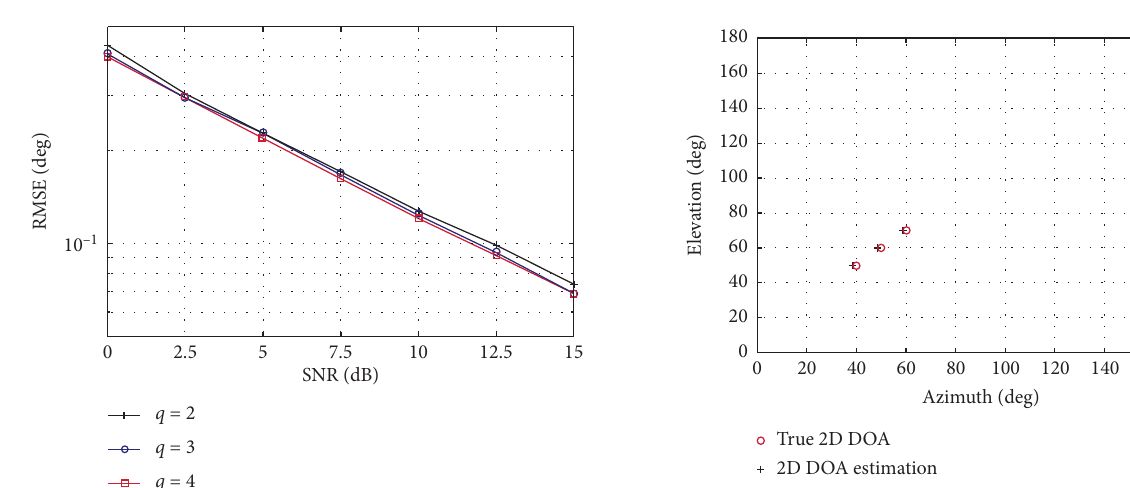
Figure 8: RMSE of the proposed algorithm with different q versus SNR.